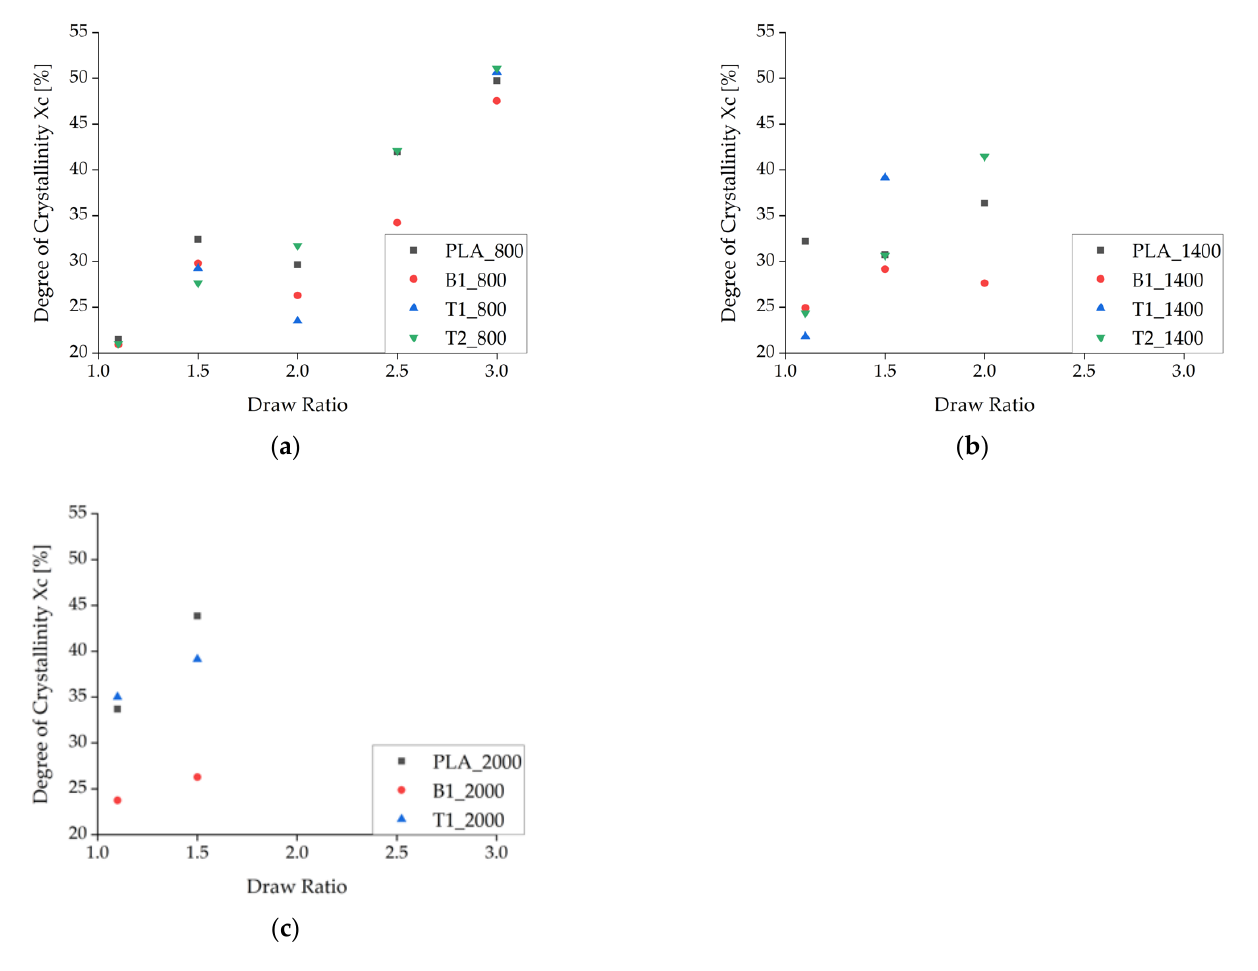
Figure 9. Degree of crystallinity (X c ) calculated from enthalpy as the draw ratio increases. The data represent take-up velocities of ( a ) 800 m/min, ( b ), 1400 m/min, and ( c ) 2000 m/min.